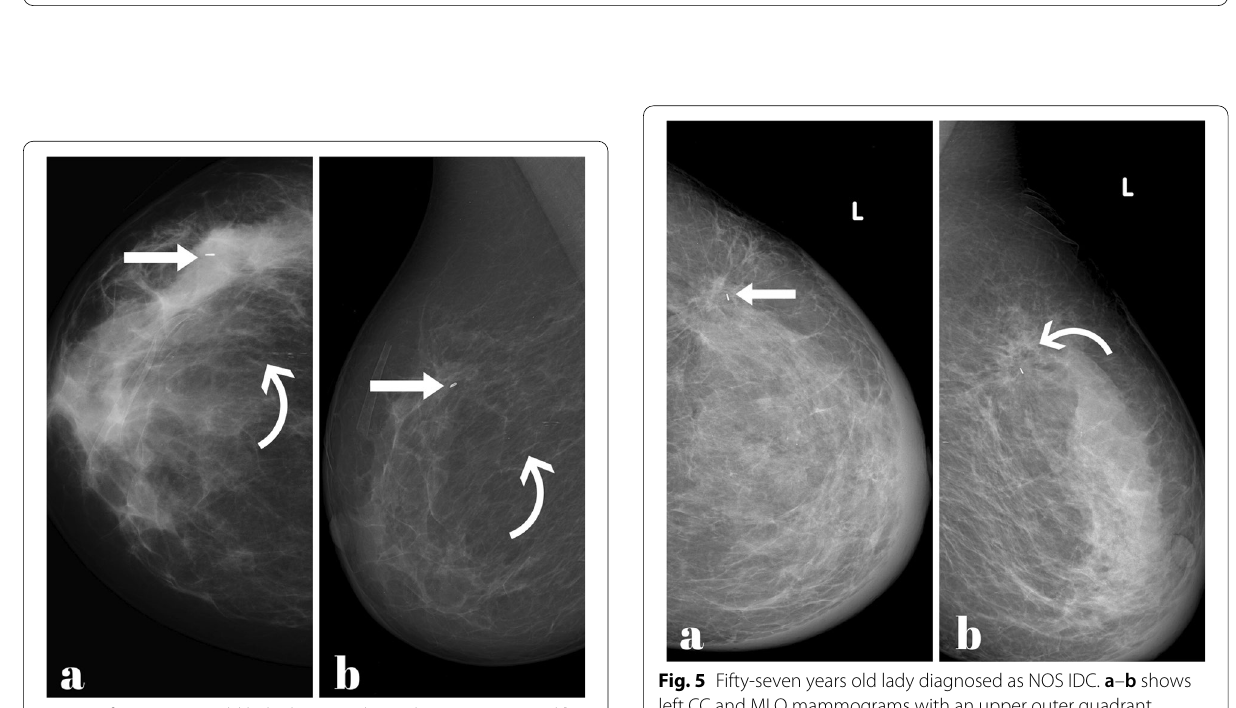
Fig. 3 Sixty years old lady diagnosed as locally advanced breast cancer (LABC) of not otherwise specified (NOS) infiltrating ductal carcinoma [IDC] type. a – b The CC and MLO views showing the centrally located surgical clip. c – d show the ill‑defined, heterogeneously hypoechoic mass with centrally located hyperechoic surgical clip